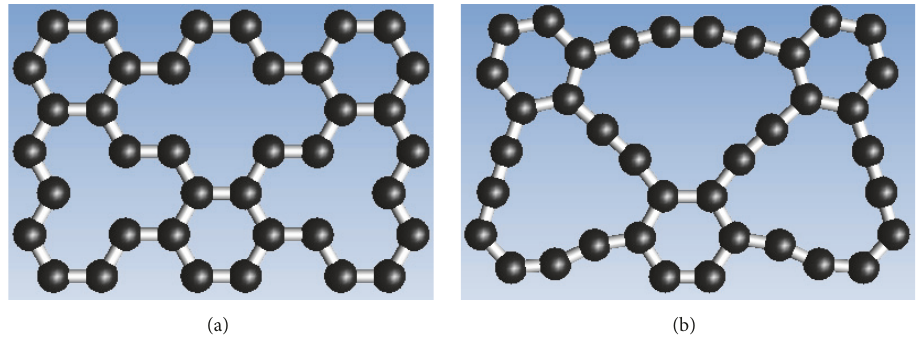
Figure 13: Graphene editing based on physical meaning.